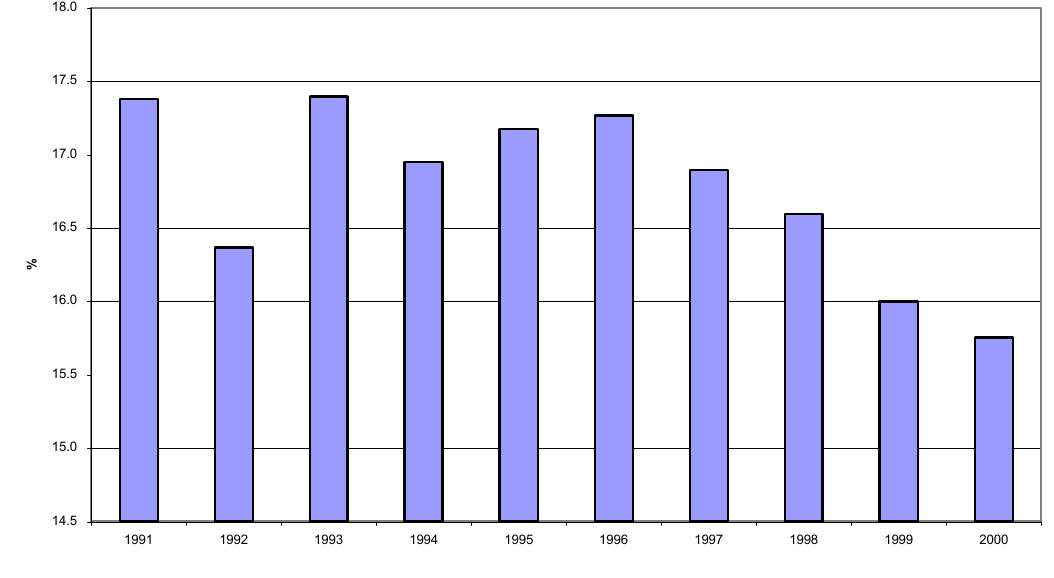
Figure 1: Medical scheme coverage